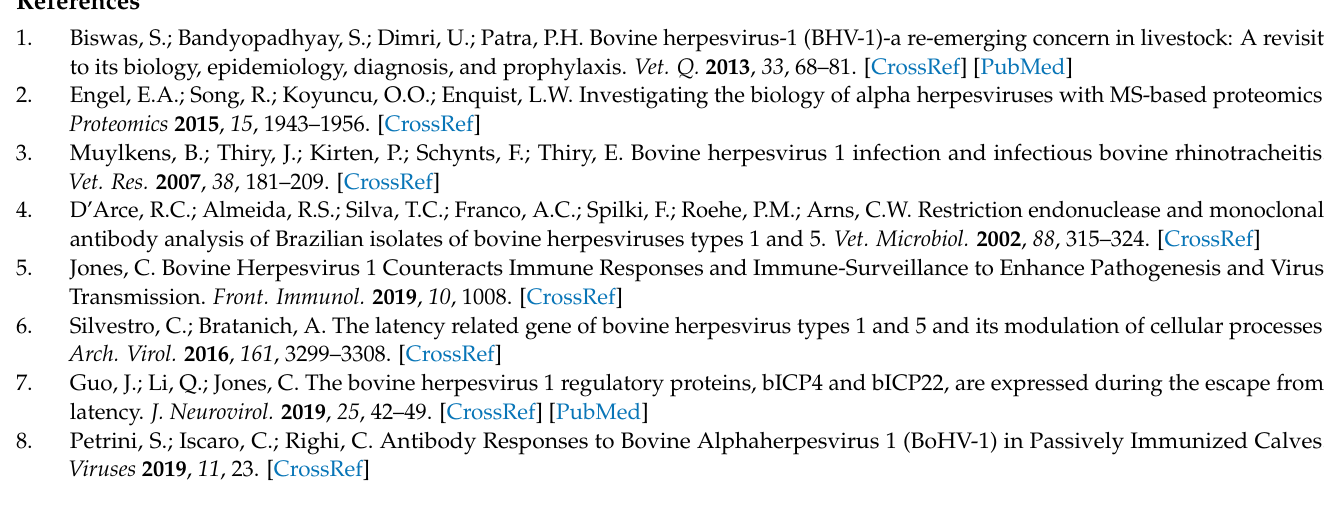
assay in 96-well plates, with two-fold dilutions of serum against 100 TCID50 of either BoHV-1 strain HB06 or BoHV-5 strain EVI 88/95. The VN titers were expressed as the reciprocal of the highest serum dilution that prevented the development of cytopathic effect (CPE) after 72 h of incubation at 37 °C. Figure S6. Antibody ELISA assays. Anti-BoHV-1 gB antibody (A), gE antibody (B), and serum sIgA (C) were determined in serum from vaccinated animals at different dpi. Serum samples with blocking % of 55% and greater are considered positive for BoHV-1 gB antibodies. Serum samples with an S/N ratio of 0.60 and lower are considered positive for BoHV-1 gE antibodies. Figure S7. IFN- γ detection after vaccination. Table S1. The primers used in this study. Table S2. The total identified virion proteins of the three strains after LC-MS/MS peptides identification and database search using UNIPROT. Table S3. Comparative upregulated and downregulated proteins detected in wt BoHV-1, double mutant BoHV-1 gG-/tk-, and the triple mutant BoHV-1 gG-/tk-/gE-. Table S4. Mean number of days of fever, ocular and nasal lesions, cough, and nasal virus shedding after intranasal inoculation. Table S5. Mean number of days of fever, ocular and nasal lesions, cough, and nasal virus shedding after challenge. Table S6. Assessment of protection rates based on different scoring systems. Table S7. IL-4 detection after